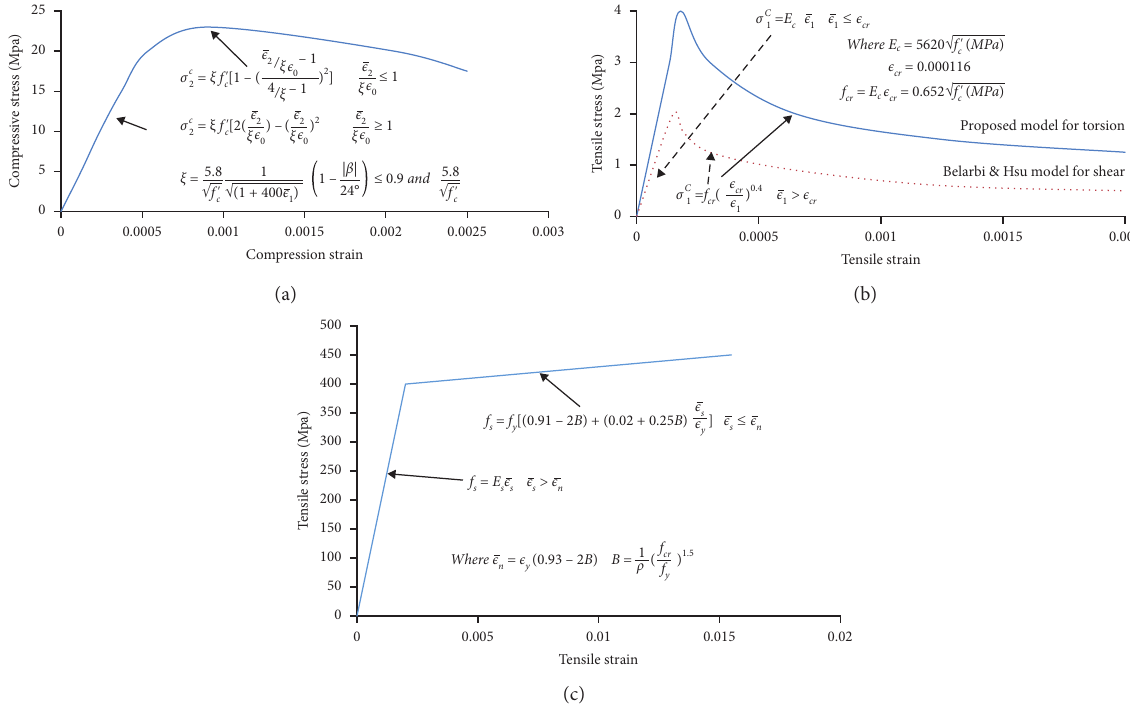
Figure 3: The constitutive relations: (a) concrete in compression, (b) concrete in tension, and (c) mild steel embedded in